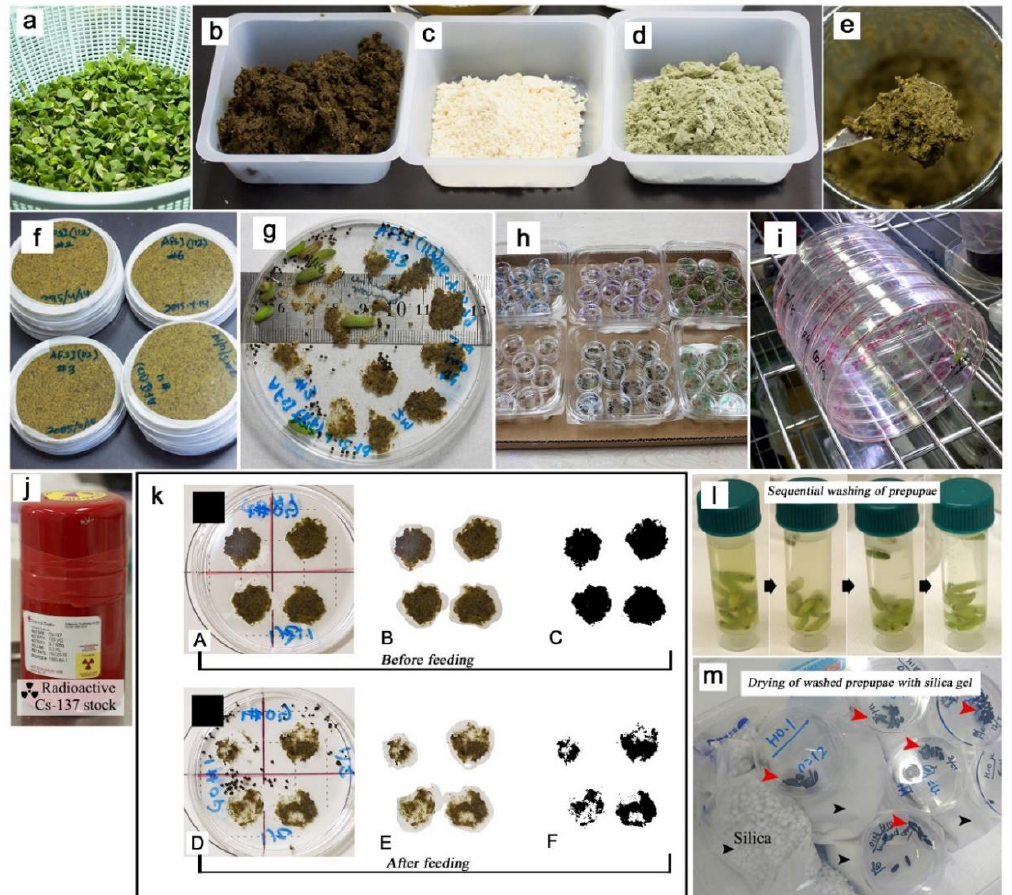
Figure A1. Materials and methods used in this study. ( a ) Separated and washed Oxalis leaves. ( b ) Fresh Oxalis leaf paste. The dry weight of this paste is considered one part. ( c ) Soy powder (one part) ( d ) Insecta F-II (two parts). ( e ) Mixing the fresh Oxalis paste, soy powder, and Insecta F-II in a glass cup using a spoon. ( f ) Plated artificial diet in Petri dishes. Dishes were labelled and sealed. ( g ) Feeding larvae an artificial diet in a 90-mm Petri dish. This panel shows a preliminary experiment to test the quality of the diet. Only 35-mm Petri dishes were used for feeding in the toxicological experiments. ( h ) The larval rearing system. In a plastic container, 35-mm Petri dishes were confined. ( i ) Isolated pupae in 90-mm Petri dishes. ( j ) Original supply of 137 CsCl (3.7 MBq in 0.5 mL). ( k ) Image analysis for areas of the artificial diet consumed by the larvae. [A–C] Images before feeding; [D–F] Images after feeding. From the original pictures [A,D], the diet areas and their surroundings were cut out [B,E], and the diet areas were further isolated by applying a darkness threshold of 133 using Adobe Photoshop. Black squares are reference scale areas of 1.0 cm 2 . Areas were then calculated using ImageJ. ( l ) Sequential washing of the prepupae (light green objects) with deionised water to remove the artificial diet from their bodies before measuring the radioactivity concentrations of 137 Cs. ( m ) Drying of the washed prepupae with silica gel (black arrowheads) for measuring the radioactivity concentrations of 137 Cs. Dried prepupae were black and hard (red arrowheads).